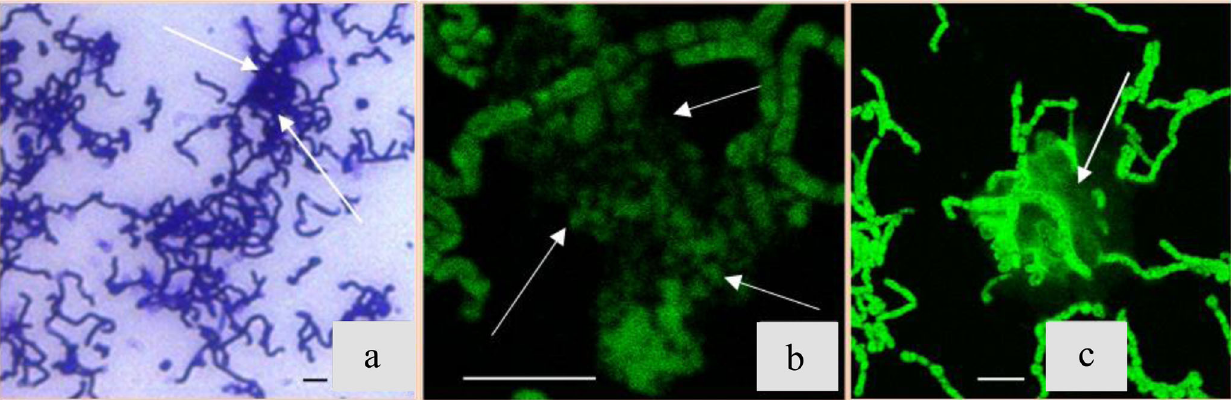
Fig. 3 B. cereus at the second stage of the growth (15 – 24 h after inoculation). a Light-microscopy image with crystal violet staining in the sample taken after 24 h after inoculation; white arrows show ECM thickening. b Confocal microscopy image with Sytox green staining (eDNA). c Confocal microscopy image with Thio fl avin T staining (amyloid structures); All scale bars correspond to 5